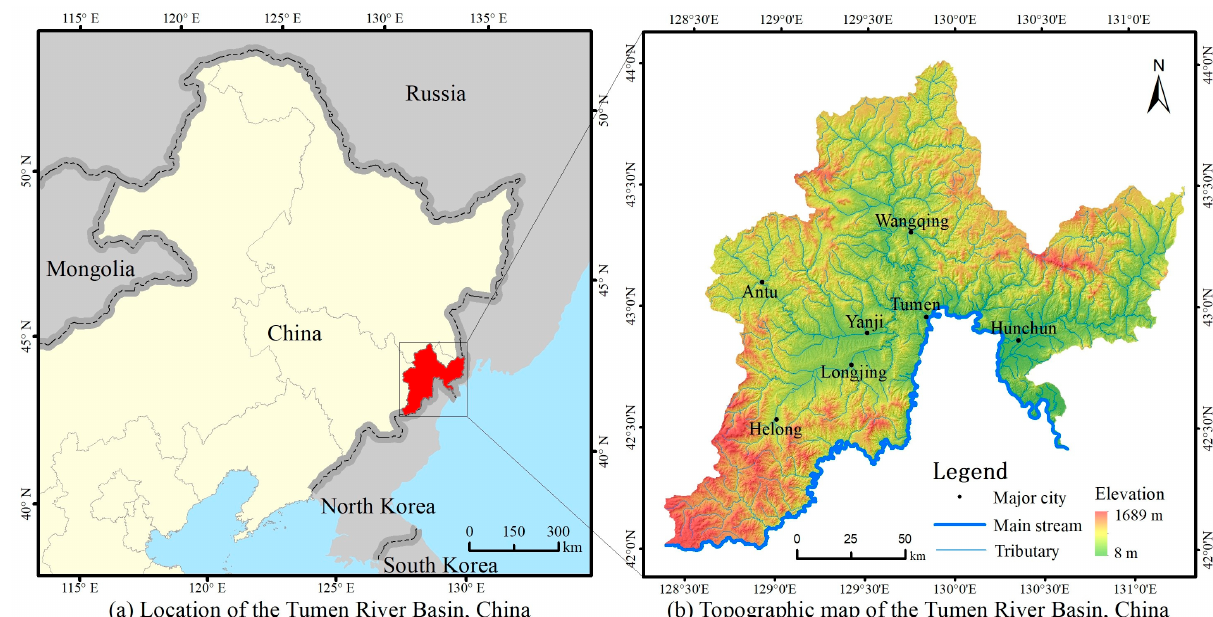
Figure 1. Maps of Tumen River Basin, China.